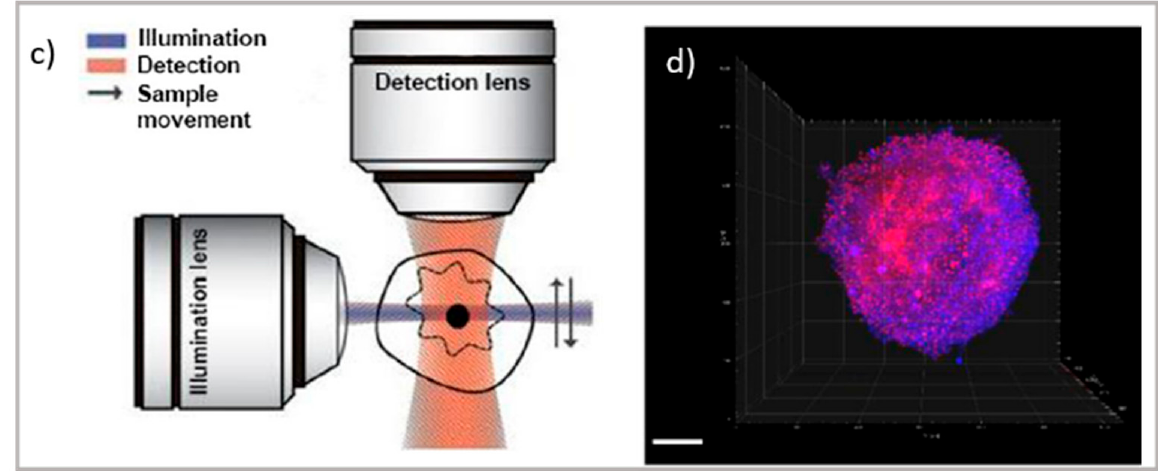
Figure 2. Top: schematic illustration of ( a ) TIRF microscope [66] and TIRF micrographs; ( b ) SLBs formed on planar silica with auto-fluorescent felodipine. Scale bar = 20 mm (adapted with permission from [61]; copyright (2020), the authors; Angewandte Chemie published by Wiley-VCH GmbH); bottom: schematic illustration of ( c ) the LSFM microscope and tomography; ( d ) LSFM of large multicellular tumor spheroids (Scale bar 100 µ m); readapted from [63] (copyright (2019), with permission from Elsevier).